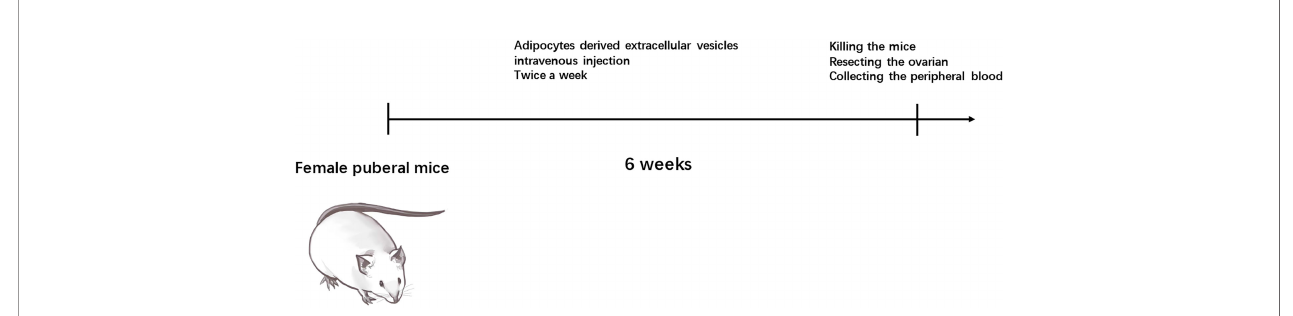
FIGURE 8 | Timeline for the recipient mice treated with diverse EVs in promoting PCOS